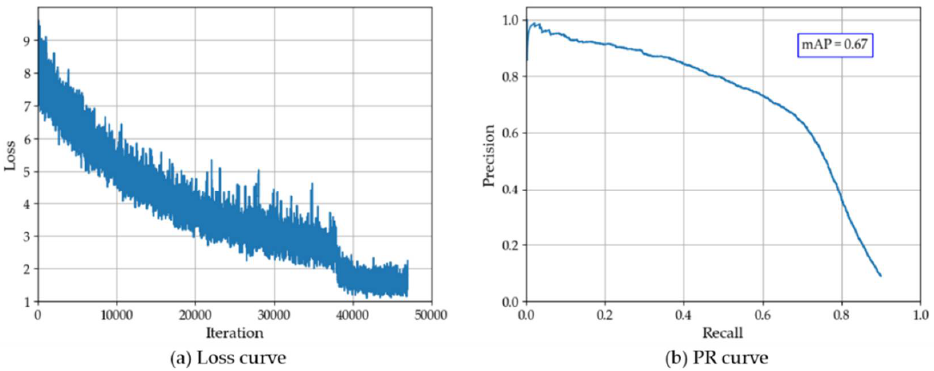
Figure 10. The stem detection by Faster RCNN under natural scenarios. ( a ) long-distance and strong lighting intensity; ( b ) close-distance and backlighting; ( c ) close-distance; ( d ) backlighting; ( e ) strong lighting intensity; ( f ) long-distance.